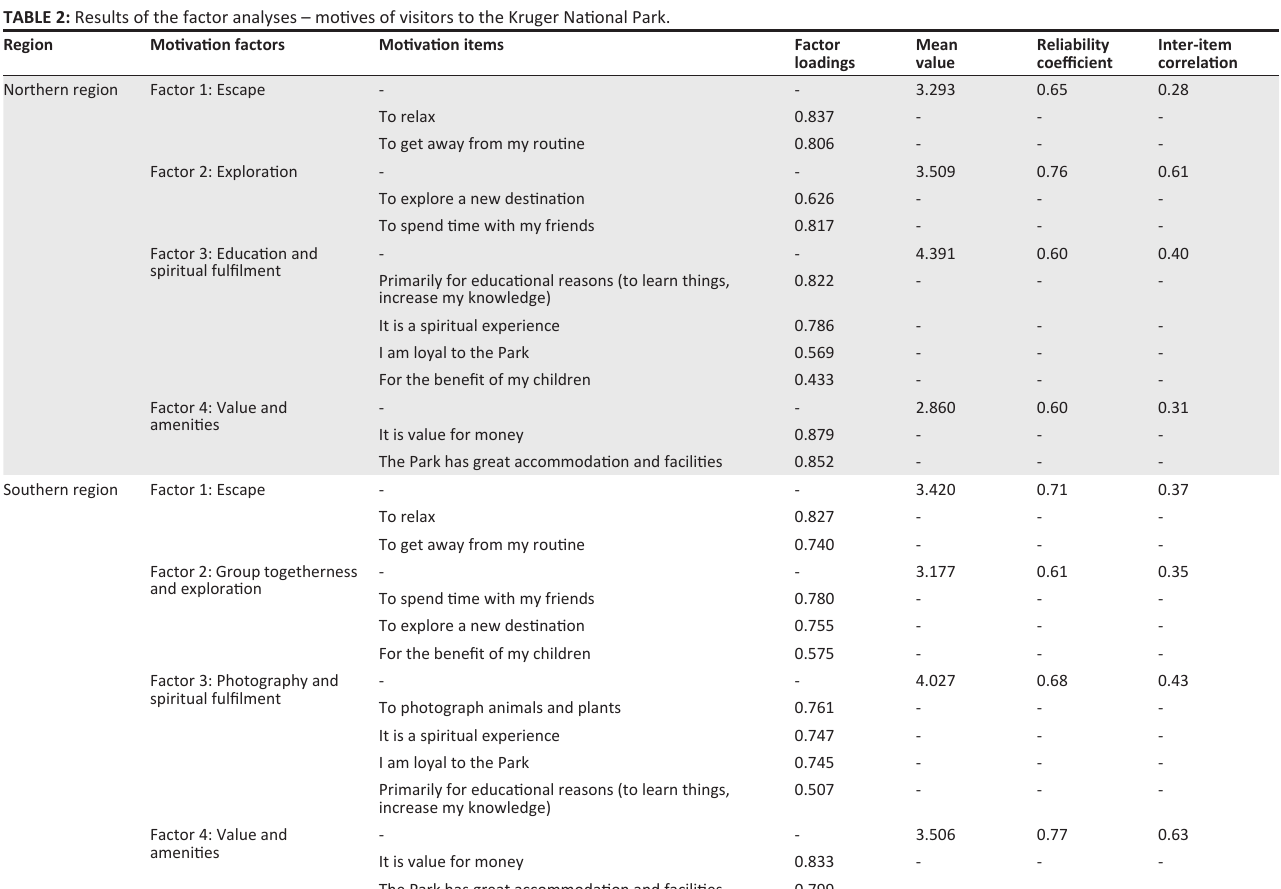
TABLE 2: Results of the factor analyses – motives of visitors to the Kruger National Park.